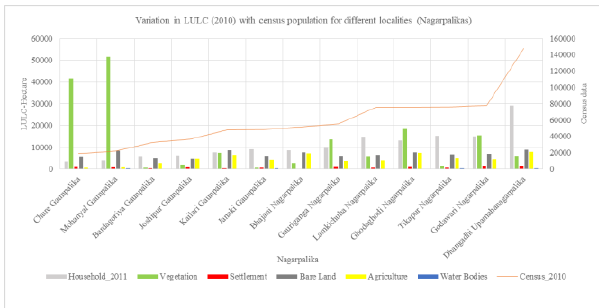
Figure 4: Variation in LULC (2010) with census population for different localities (Nagarpalikas)